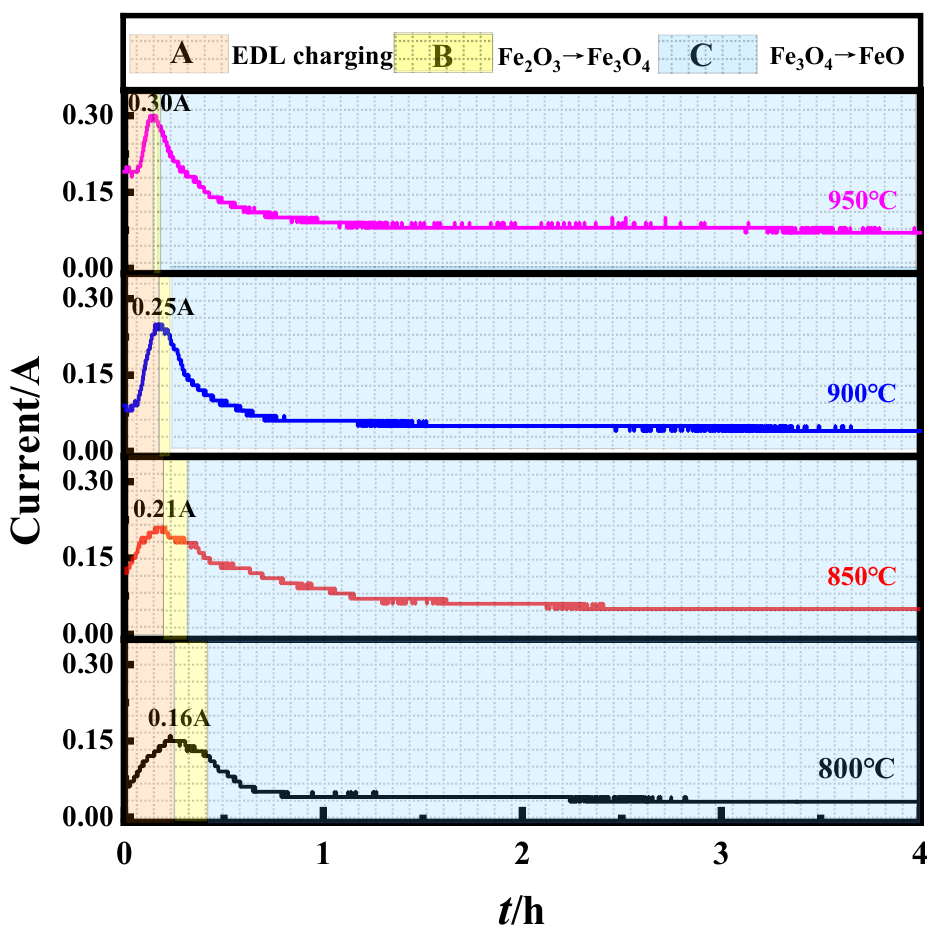
Figure 4. The current-time curves during electrolysis. Table 1. Absolute value of slope after linear fitting of stage A and B. Temperature Stage A